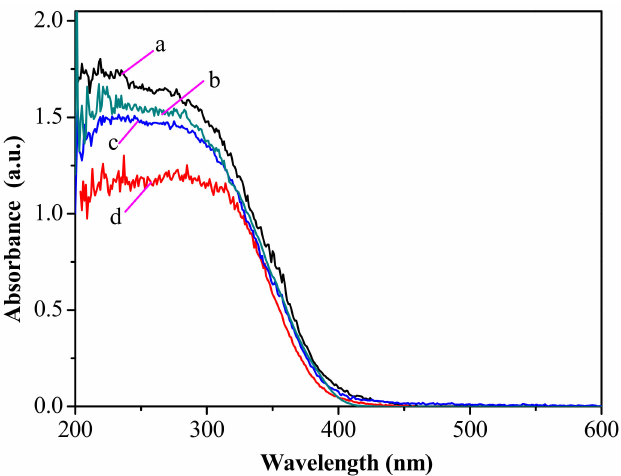
Figure 6. UV-vis diffuse reflectance spectra of Ba(II)/TiO 2 –MCM-41—a, P25—b, TiO 2 –MCM-41—c, and TiO 2